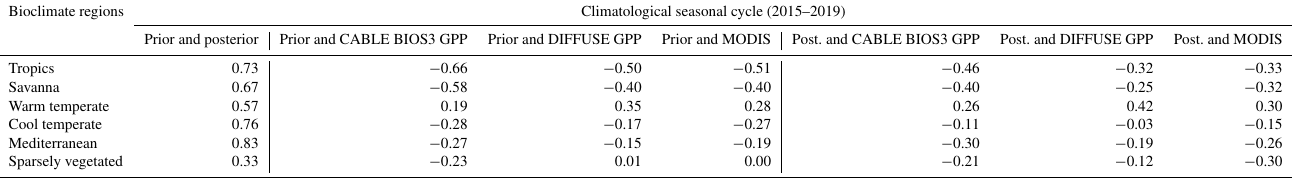
Table H1. The Pearson correlation ( R ) values of prior and posterior climatological seasonal fluxes with GPP fluxes derived from the respec- tive CABLE BIOS3, MODIS, and DIFFUSE models.